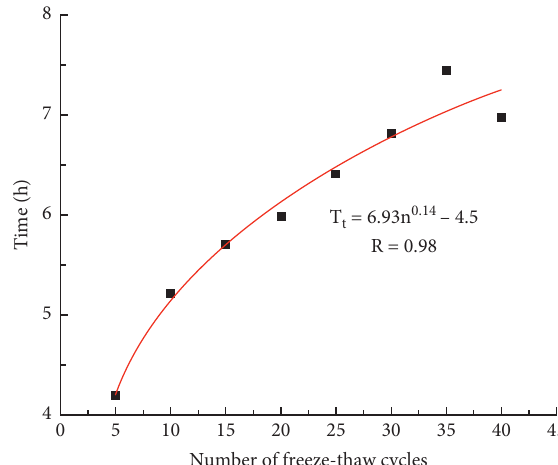
Figure 4: Time required for a complete freeze-thaw cycle as a function of freeze-thaw